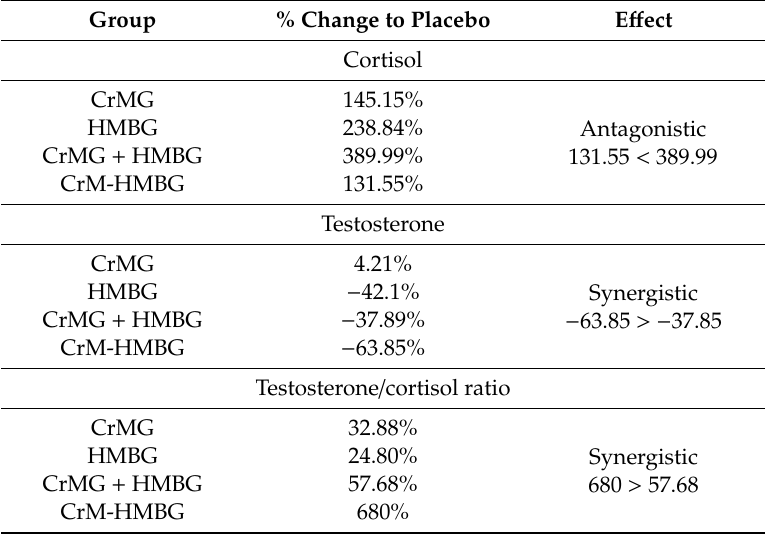
Table 5. Determination of the e ff ect of the combination of